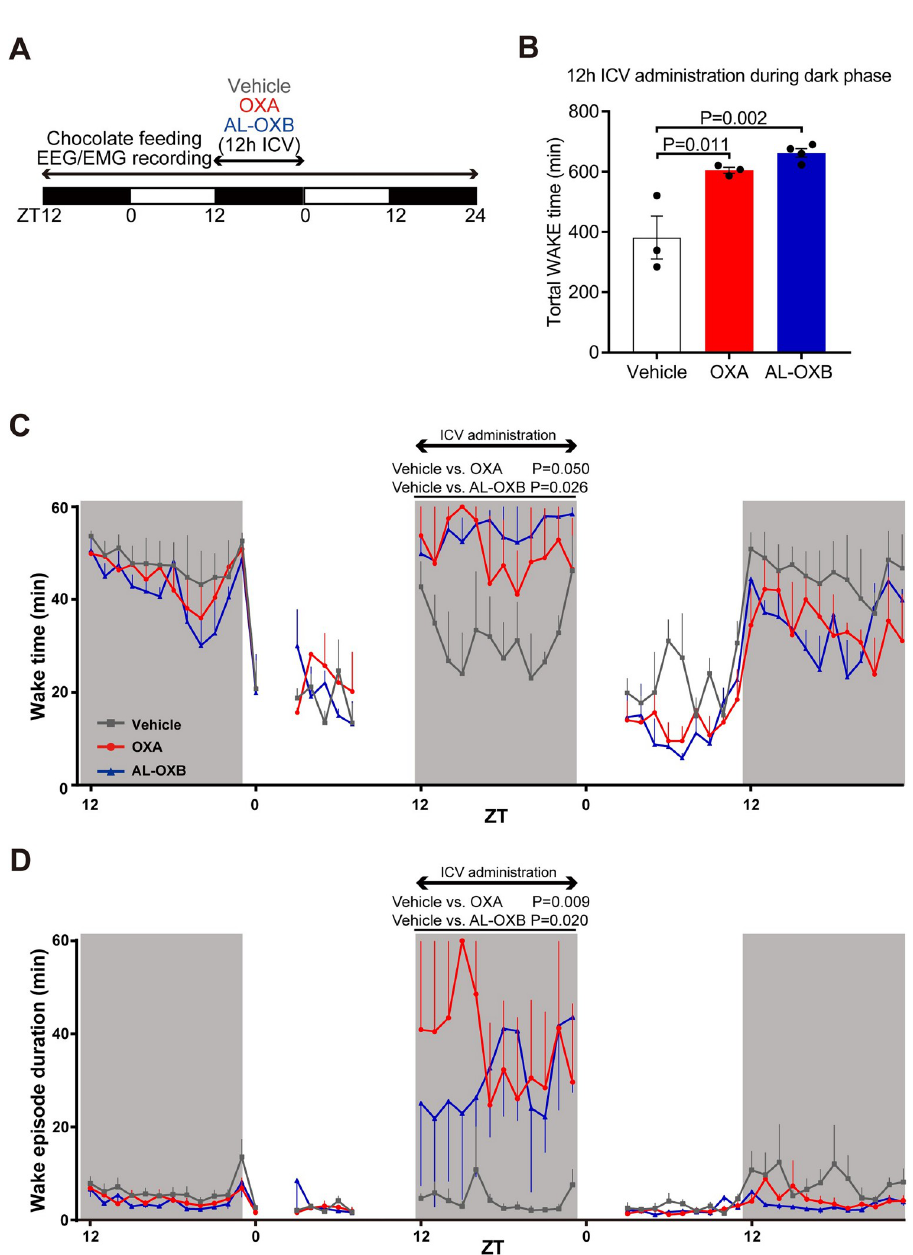
Fig 4. Effect of continuous ICV administration of OXA and AL-OXB during dark phase on sleep-wake cycle in OXKO mice. (A) Experimental schedule of ICV infusion and EEG/EMG recording. (B) Total wake time duration during 12-h ICV administration. Data represent the means ± SEM from 3 mice. Statistical analysis: one-way ANOVA followed by Bonferroni’s multiple comparisons test. (C and D) Hourly plots of wake time (C) and wake episode duration (D) before, during and after continuous ICV administration. Data represent the means ± SEM from 3 mice. Statistical analysis: two-way repeated-measures ANOVA. the conditioned place preference test conducted at ZT4-7 (Fig 5A). We chose to perform the